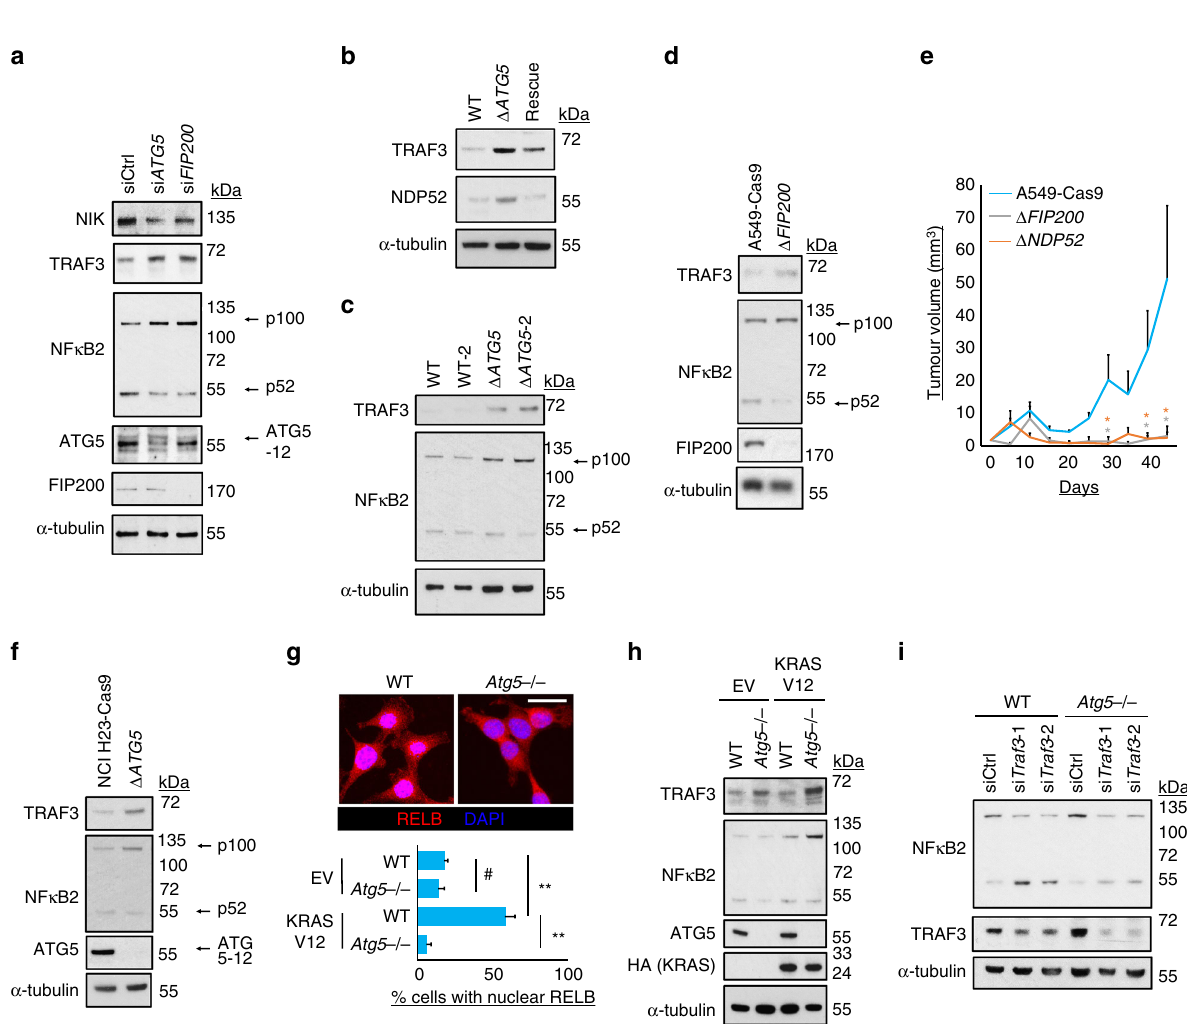
(Fig. 5c, Supplementary Data set 1). Strikingly, GSEA identi fi ed that, just as with inhibition of autophagy, the top-ranking cor- relation of the transcriptional signature of RELB de fi ciency was